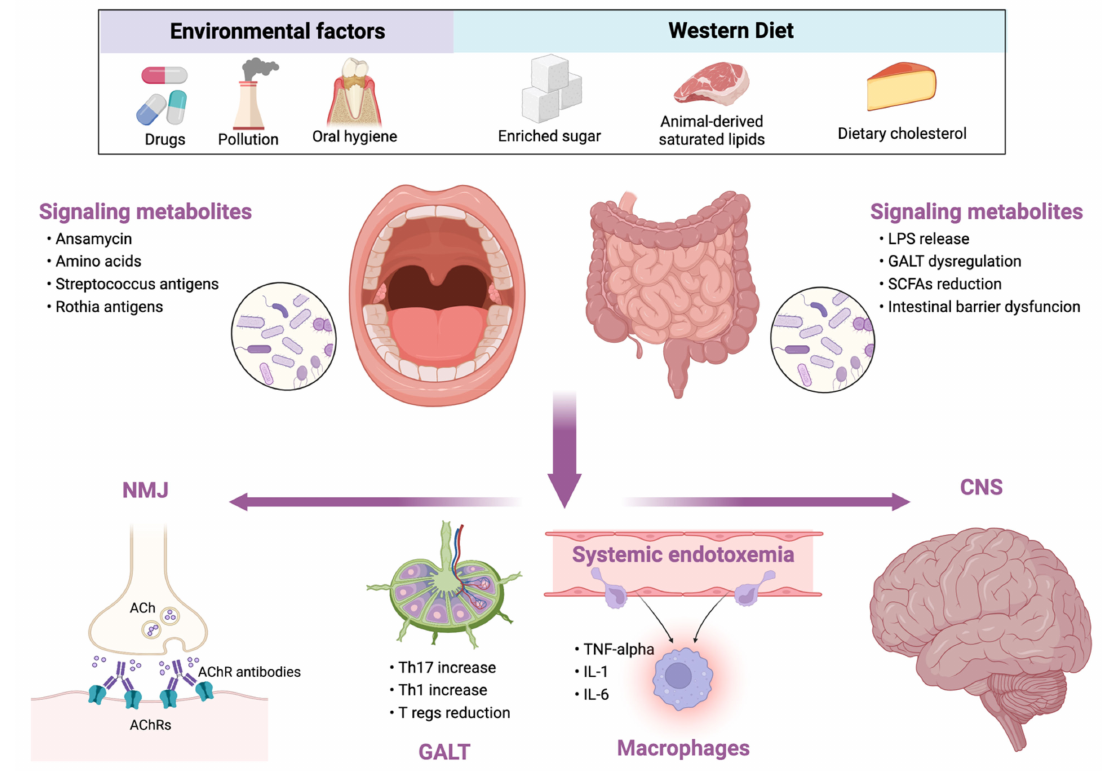
Figure 1. Relationship between external influencing factors and human microbiota and its conse- quences in myasthenia gravis. LPS, lipopolysaccharide; GALT, gut-associated lymphoid tissue; SCFAs, short-chain fatty acids; NMJ, neuromuscular junction; ACh, acetylcholine; AChRs, acetylcholine receptors; Th, T helper cell; Tregs, T regulatory cells; TNF, tumor necrosis factor; IL, interleukin; CNS, central nervous